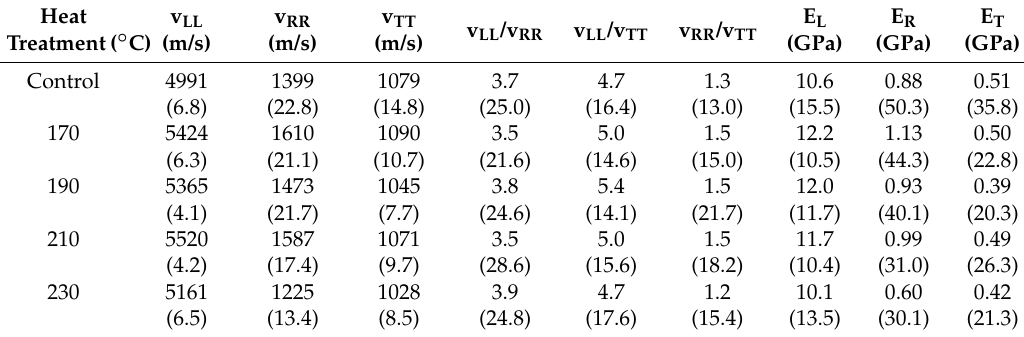
Table 2. Mean velocity of ultrasound in longitudinal- (v LL ), radial- (v RR ) and tangential wood direction (v TT ), elastomechanical anisotropy (v LL /v RR , v LL /v TT , v RR /v TT ) and mean moduli of elasticity (E L —longitudinal, E R —radial, E T —tangential) of heat-treated structural timber (2nd row present Coef. of variation (%)).